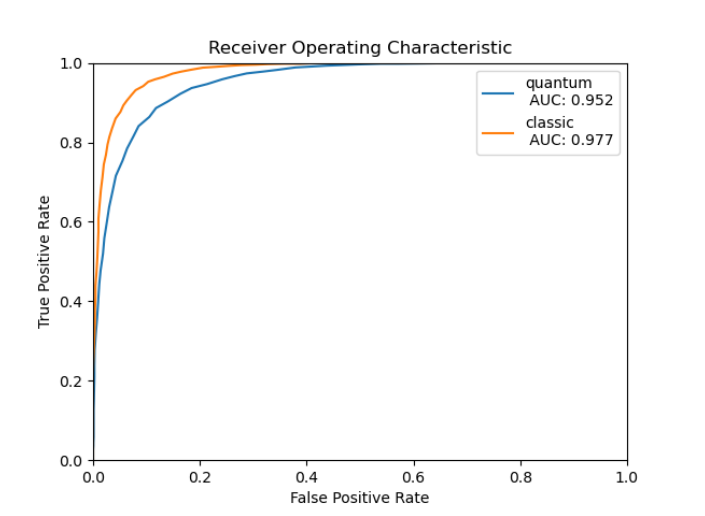
Figure 9. ROC curve and AUC for quantum anomaly detection algorithm (blue) and the classic counterpart (orange).